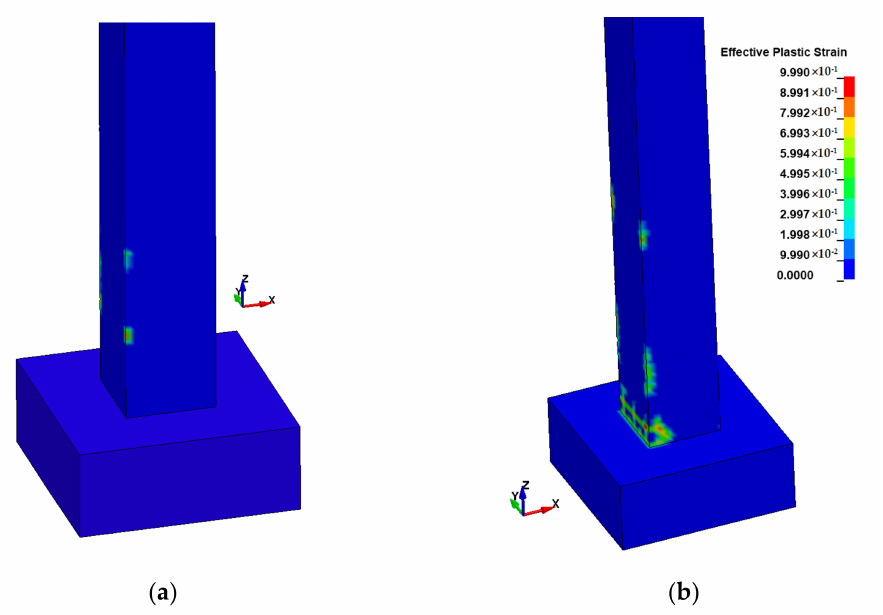
Figure 10. Column (C400) damage contour for car impact velocity of V = 40 km/h: ( a ) impacted by Econoline and ( b )